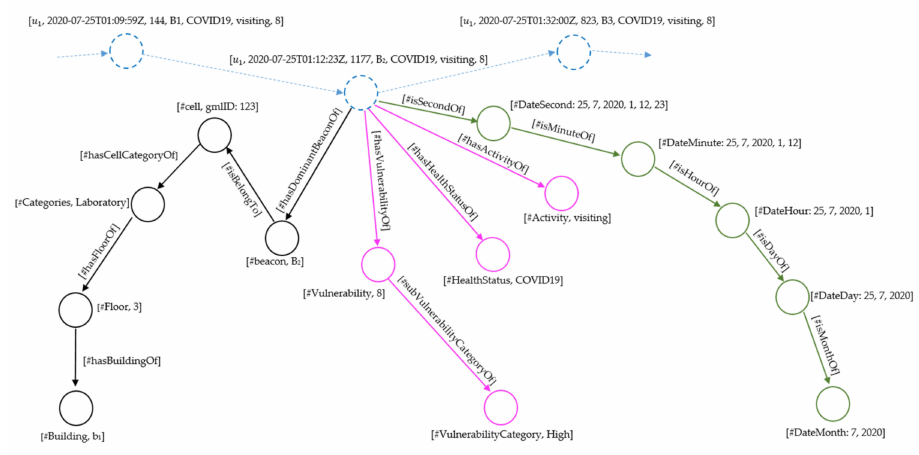
Figure 7. An example of the proposed graph-based indoor trajectory